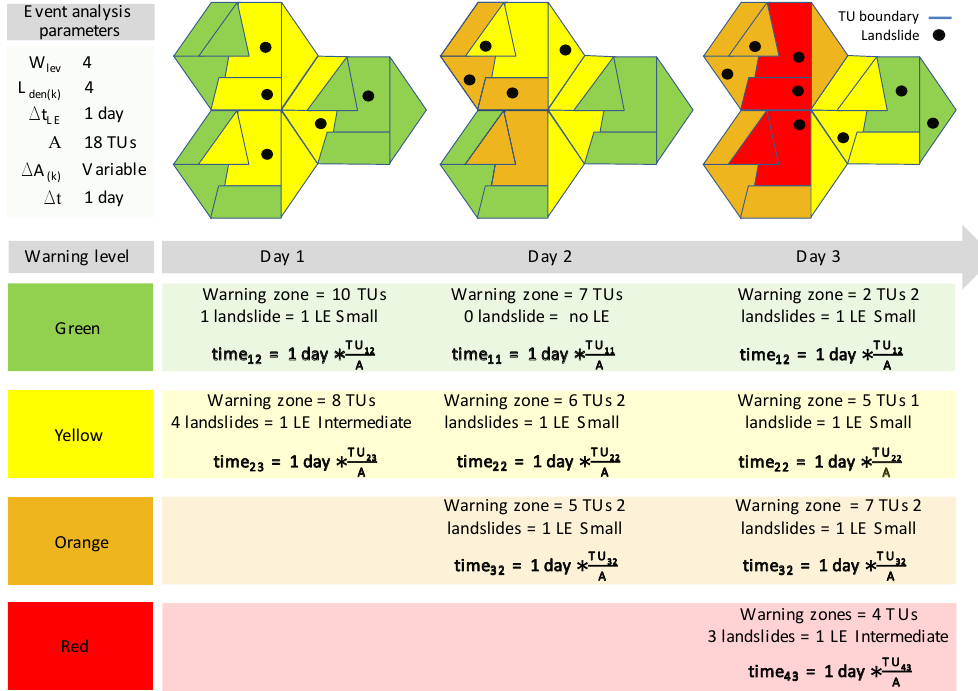
Figure 4. Computation of time ij elements as a function of warning levels and LEs occurred for each warning zone for three hypothetical days of